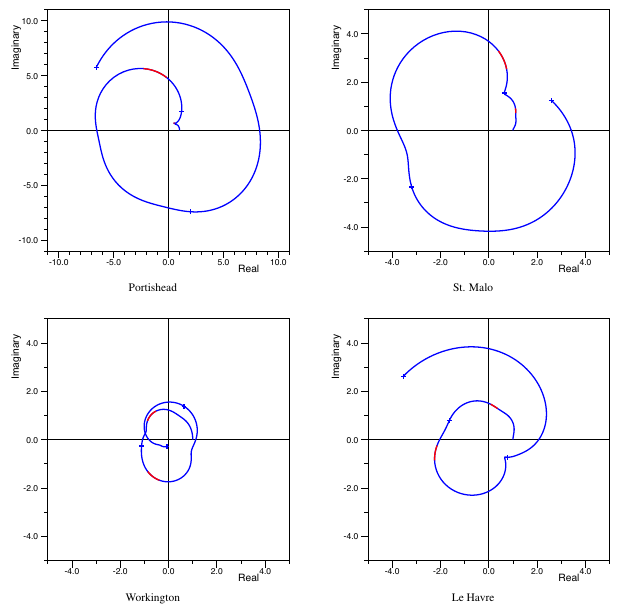
Fig. 4. Polar plots showing the real and imaginary components of the response function at Portishead, St. Malo, WorkingtonandLeHavreintherange0to30rad/day. Thefunctionhasthevalue(1,0)attheorigin. Thecrossesmarkmultiplesof10rad/day.Theredsectionsindicatethepositionofthediurnalandsemi-diurnal tidalbands.